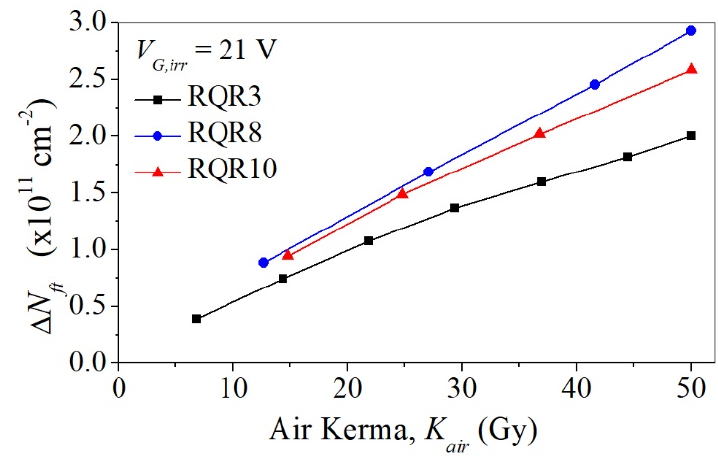
Figure 4. Radiation-induced oxide fixed-trap density versus K air .